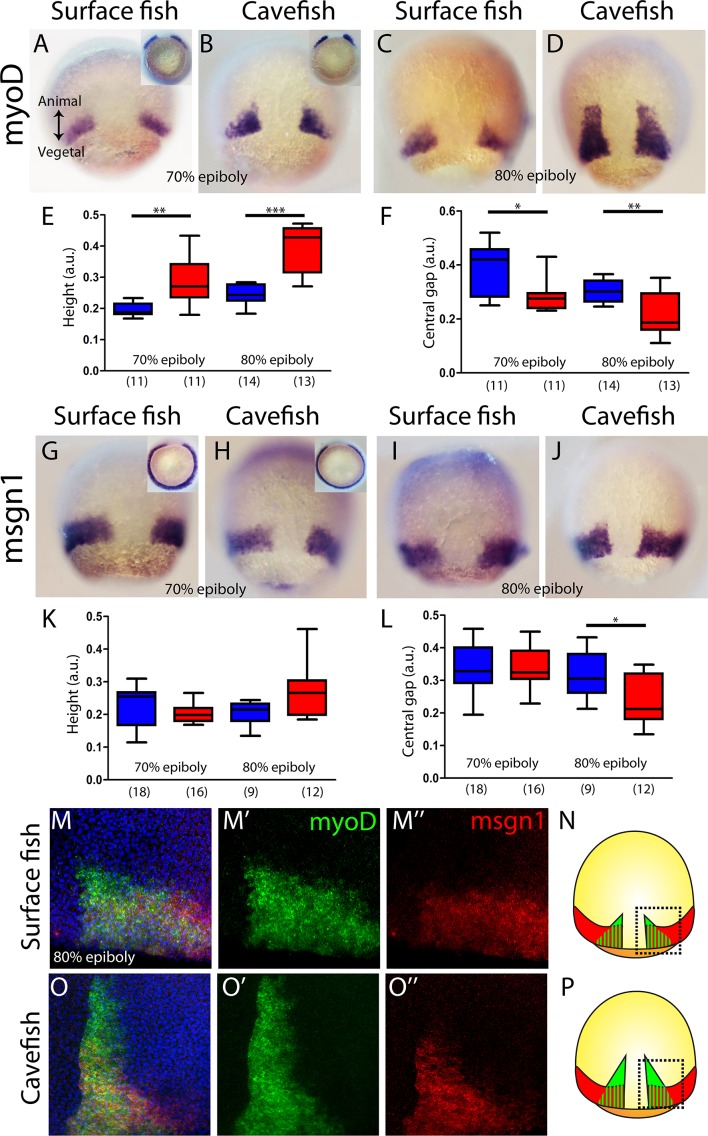
Internalization of paraxial mesoderm in surface fish and cavefish.(A–D) Expression of myoD in surface fish (A, C) and cavefish (B, D) at 70% and 80% epiboly (A, B and C, D, respectively). Insets in panel (A) and (B) show the corresponding embryos in a vegetal view. (E) Quantification of height in myoD-labeled embryos at 70% and 80% epiboly (left and right, respectively). (F) Quantification of the central non-expressing zone in myoD-labeled embryos at 70% and 80% epiboly (left and right, respectively). (G–J) Expression of msgn1 in surface fish (G, I) and cavefish (H, J) at 70% and 80% epiboly (G, H and I, J, respectively). Insets in panels (G) and (H) show the corresponding embryos in a vegetal view. (K) Quantification of height in msgn1-labeled embryos at 70% and 80% epiboly (left and right, respectively). (F) Quantification of the central non-expressing zone in msgn1-labeled embryos at 70% and 80% epiboly (left and right, respectively). (M–M’’ and O–O’’) Confocal projection (20–30 µm) showing the expression of myoD (green) and msgn1 (red) in double-stained surface fish and cavefish embryos (M–M’’ and O–O’’, respectively) at 80% epiboly. DAPI was used as a counterstain (blue nuclei). (N, P) representations of surface fish (N) and cavefish (P) embryos, indicating in black dashed lines the regions of interest showed in panels (M) and (O). Mann-Whitney tests were performed. **, p = 0.0025 (E, left), ***, p = <0.0001 (E, right), *, p = 0.0181 (F, left), **, p = 0.0094 (F, right), *, p = 0.0209 (L, right). Embryos in dorsal views, animal pole on top; insets in vegetal view, dorsal on top.